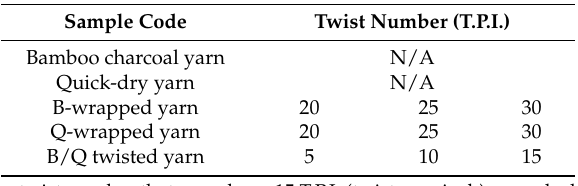
Table 2. Parameters of wrapped/twisted functional composite yarns. Q: Quick-dry, B: Bamboo charcoal, and D: Denier.